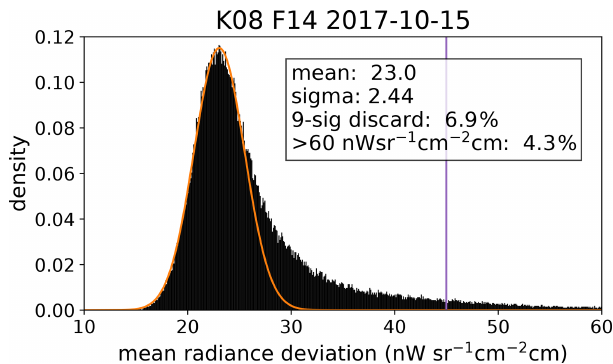
Figure 10. Distribution of spectrally averaged absolute differences from the horizontal median value for the 14th flight of the WISE campaign. A Gaussian curve (orange) is fitted to the left hand side of the distribution. The vertical bar (purple) shows the chosen 9 σ threshold. 4.3% of all values lie outside this plot.